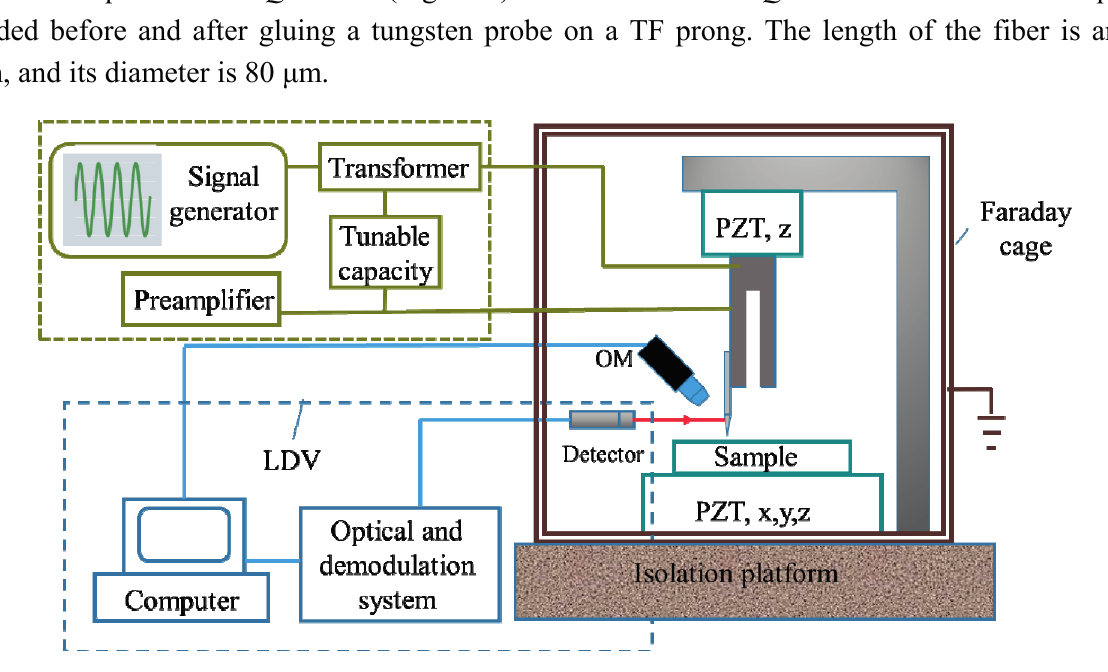
Figure 2. Setup of the frequency spectrum measurement system using an LDV and an electrical feedback mode.